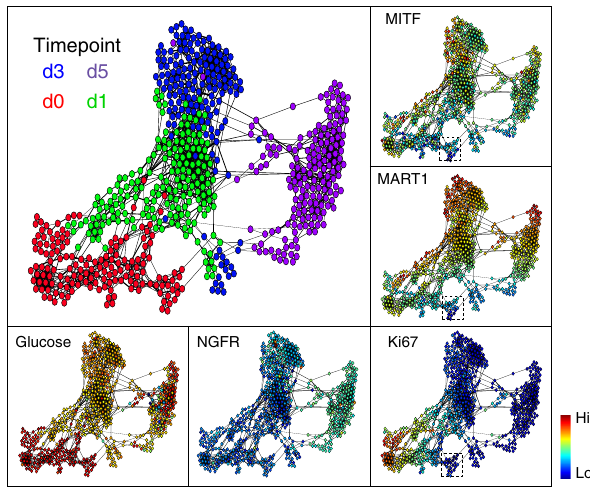
Fig. 2 Visualization of single-cell data by FLOW-MAP. Each dot represents an individual cell. The distance between each pair of cells represents the overall multi-omic dissimilarity between them. Cell pairs that are close enough are linked with an edge in between. The colors of the dots in the main panel (upper left) represent BRAFi exposure time (0, 1, 3, or 5 days) of the corresponding cells. Dot colors in the other panels represent the abundance of each marker in each cell. The dashed-line box in the panels for MITF, MART1, and Ki67 levels show a small subpopulation of day-0 cells that are slow-cycling with less melanocytic